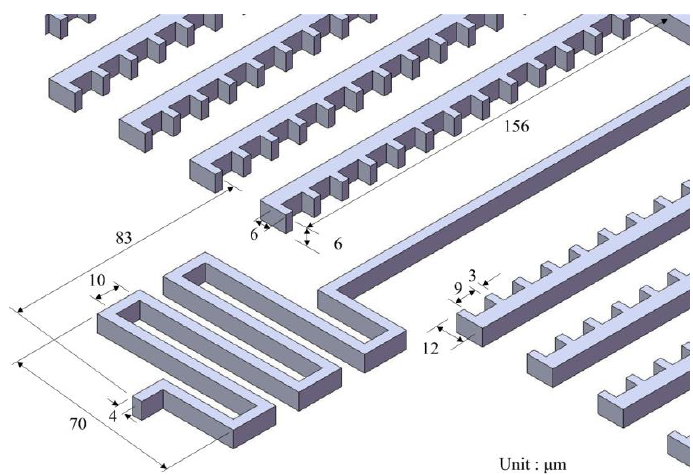
Figure 2. Dimensions of the magnetic